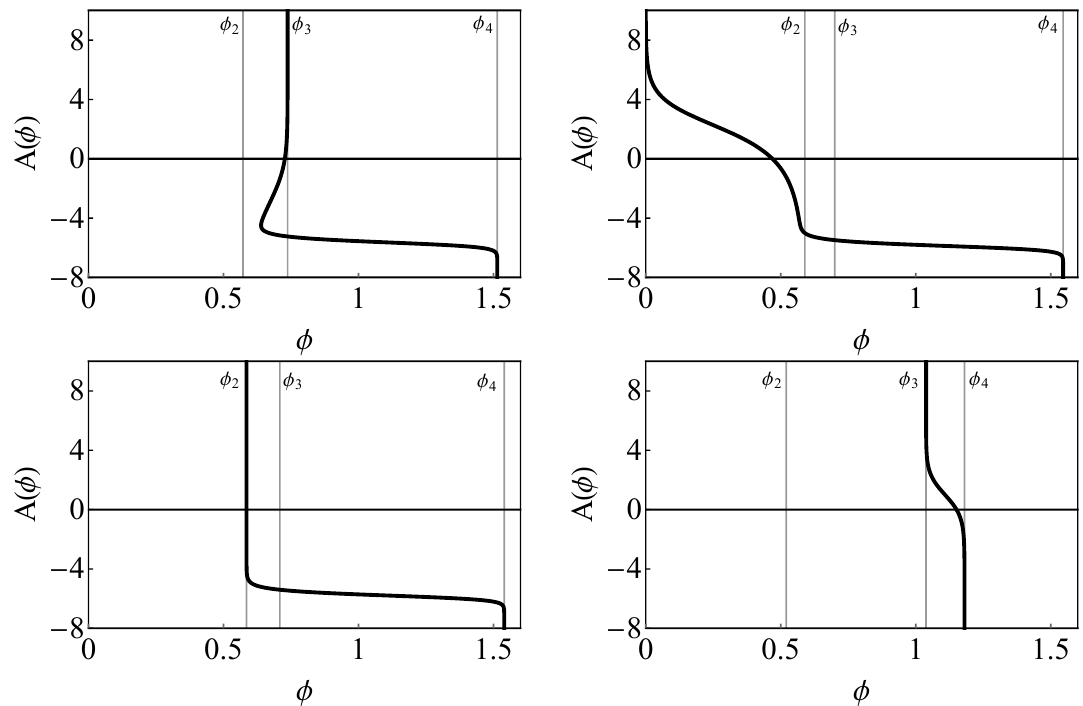
Figure 16 . Continuous interpolation between di(cid:11)erent types of exotic RG (cid:13)ows. Top left: bouncing (cid:13)ow ( g = 0 : 97). As we increase the value of g , the bouncing point gets closer to (cid:30) 2 . Top right: skipping (cid:13)ow ( g = 0 : 99). The bounce has become so large that it overpasses the minimum at (cid:30) 2 and continues to (cid:30) 1 = 0. Bottom left: irrelevant VEV (cid:13)ow ( g = 0 : 98589). It corresponds to the limiting case between bouncing (cid:13)ow and skipping (cid:13)ow, or equivalently when the tip of the bounce matches (cid:30) 2 . Bottom right: relevant VEV (cid:13)ow ( g = 0 : 84143). It corresponds to the limiting case between the bouncing (cid:13)ow and the usual, non-bouncing (cid:13)ow. Solutions are not necesarily normalized to source (cid:3) = 1 or VEV= 1. Recall that for each value of g the potential is di(cid:11)erent, so also the location of the